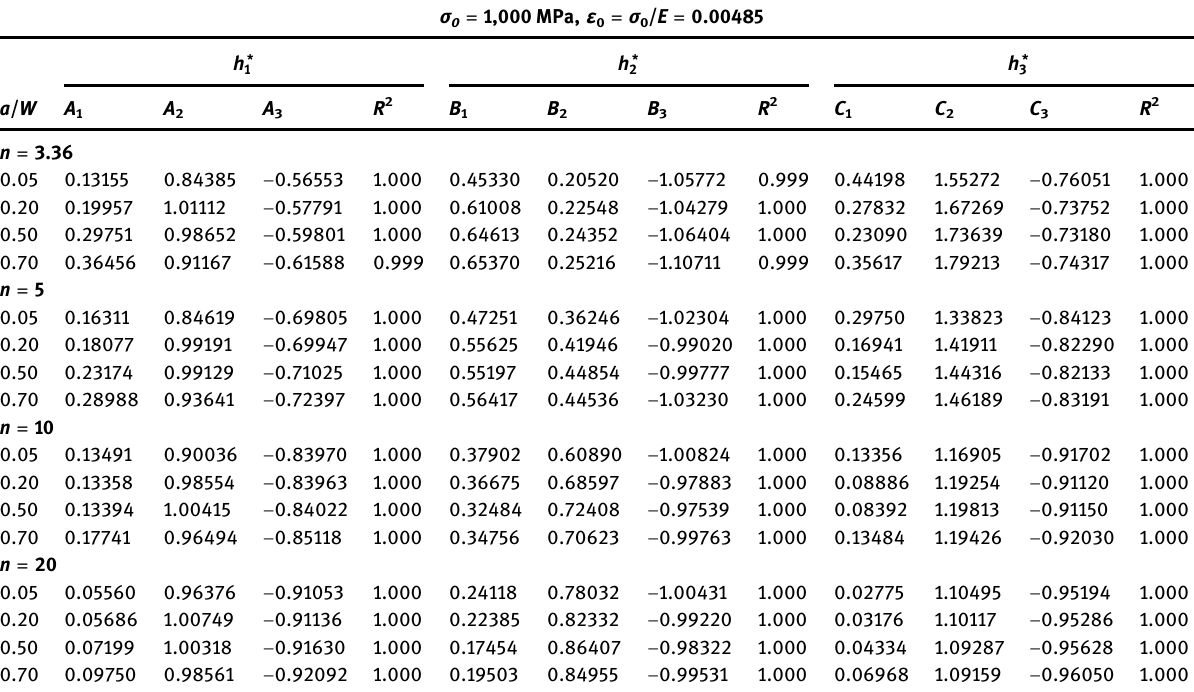
Table 4: Coe ffi cients of matching equations ( 11 – 13 ) to the obtained numerical results for materials described with the yield point σ = 1,000 0